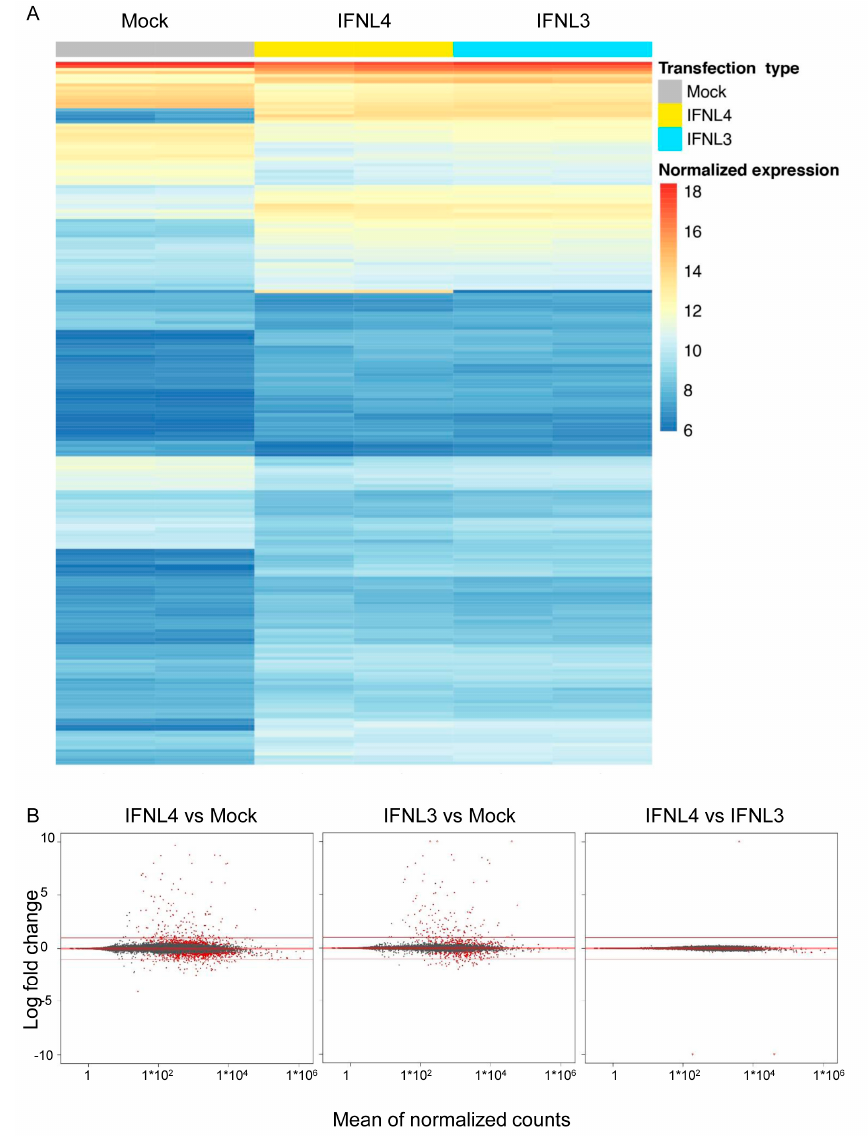
Figure 4. Gene expression profiles of cells expressing IFNL3 or IFNL4. ( A ) Heat map of 1000 most expressed genes determined by RNAseq in HuH7 cells transfected with non-tagged IFNL3 or IFNL4 for 48 h. Empty plasmid was used as a mock control. Two biological replicates were used per each group. Color represents gene expression from blue (downregulated) to red (upregulated). Fragment counts were normalized using the variance stabilizing transformation. ( B ) Generalized linear regression with counts modeled using negative binomial distribution was performed to generate MA plots (M—logarithmic fold change, A—mean of normalized counts). Genes are represented by dots; red color indicates significant change in expression between IFNL4 vs. mock, IFNL3 vs. mock and IFNL4 vs. IFNL3 . Dots on the upper part denote upregulated genes, whereas dots in the lower part indicate downregulated genes. Genes were considered differentially expressed when exhibiting an absolute log2-fold change of at least 1 and statistical significance. Note that IFNL4 and IFNL3 display identical gene expression